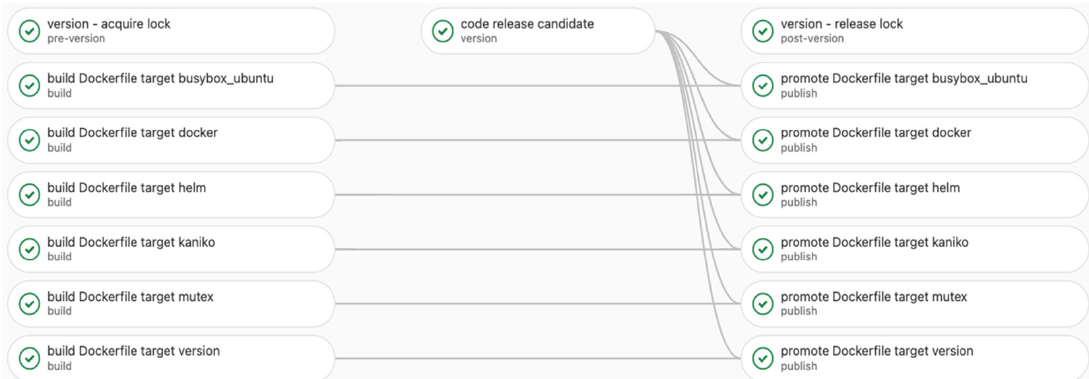
Figure 7. The pipeline diagram flow dependencies.